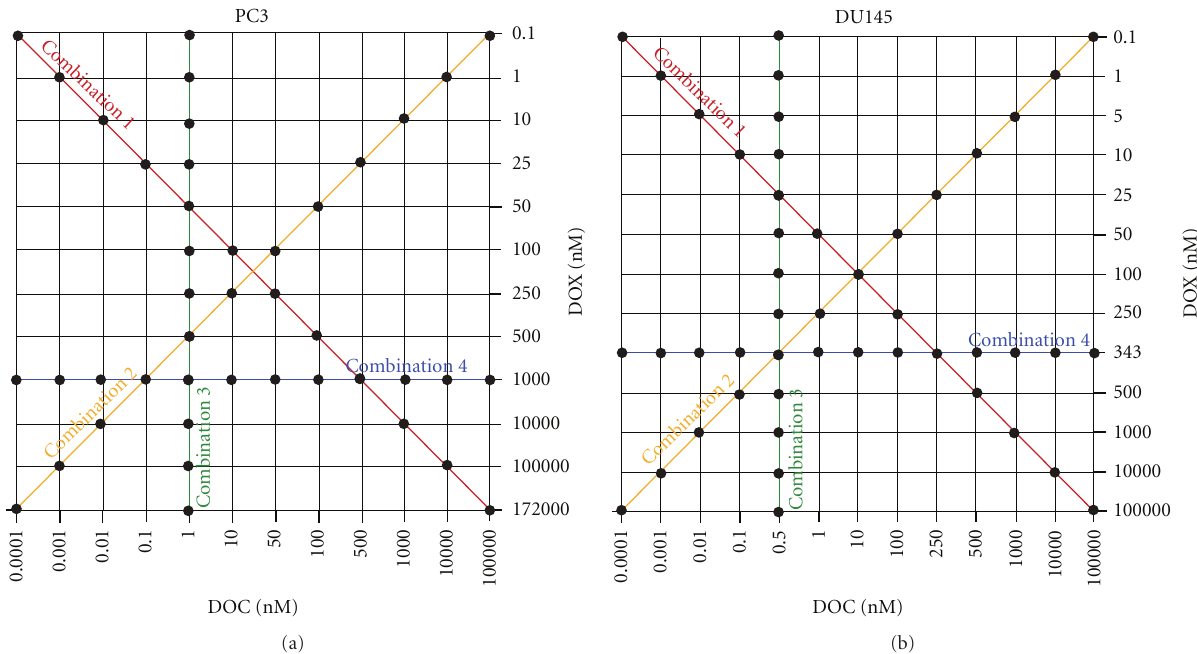
Figure 1: Drug combination settings used in this study. PC3 and DU145 cells were exposed to DOC and DOX at various concentrations and mixing ratios for 72 hours. Dots on the lines denoted as Combination 1, 2, 3, and 4 indicate data points used to determine the combination index and cytotoxicity